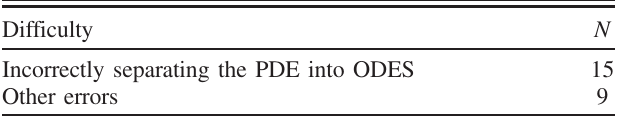
TABLE IV. Difficulties in step E1: executing the procedure of dividing the PDE to